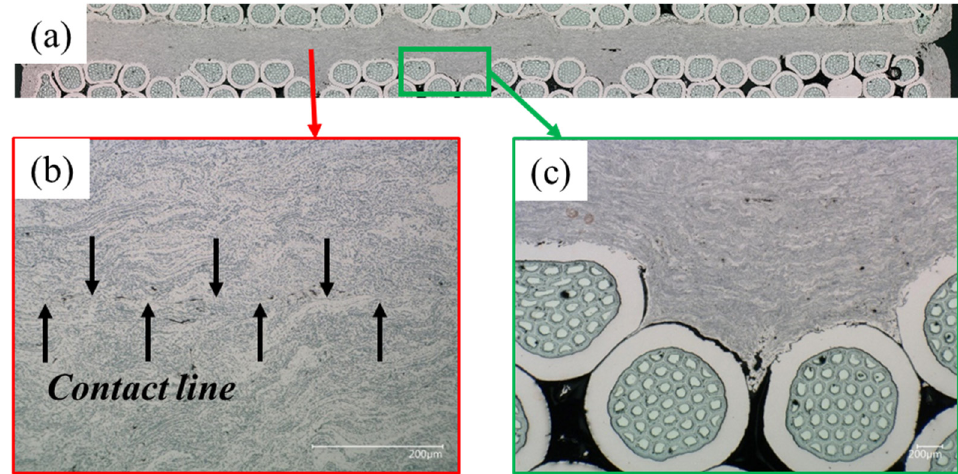
Figure 9. Diffusion-bonded joint of the copper coating of the two Nb 3 Sn cables ( a ), magnification of the contact line between the coatings ( b ) and detail of the detachment between one strand and the copper coating ( c ).